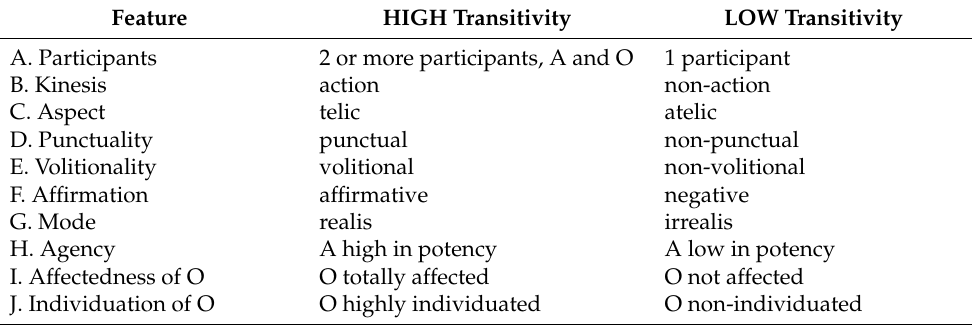
Table 1. Hopper and Thompson’s ten components of